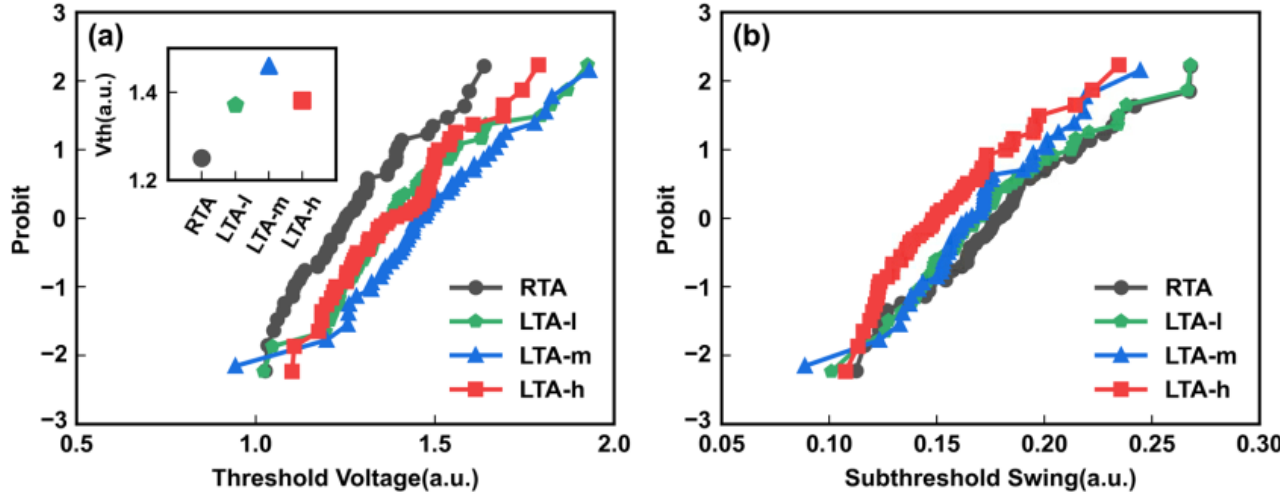
Figure 7. ( a ) Threshold voltage, the inset shows the correlation between LTA energy density and